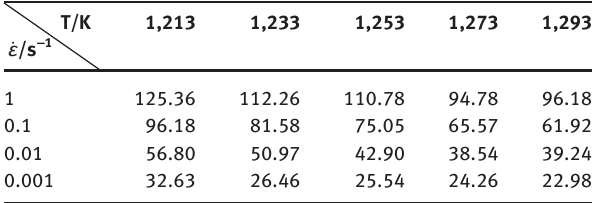
Table 2: Peak flow stress under different condition of hot compres- sive deformation